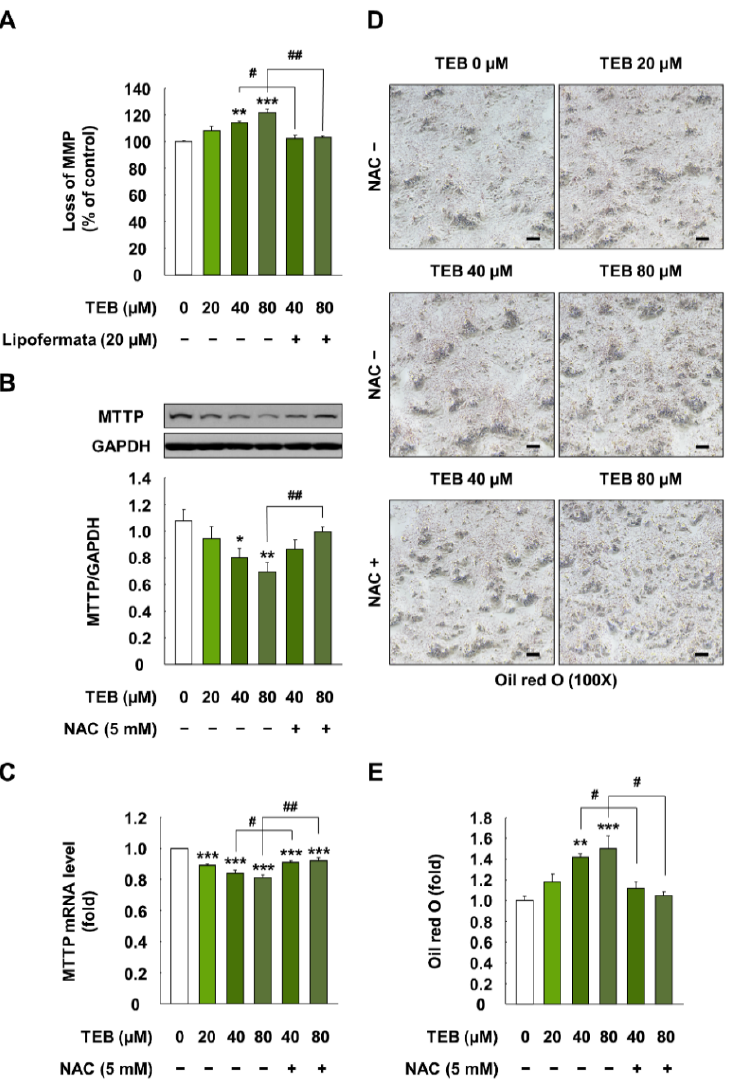
Figure 5. MMP and expression of lipid export-associated cellular indicators in HepG2 cells treated with TEB. ( A ) Loss of MMP in HepG2 cells; ( B ) protein and ( C ) gene expression levels of MTTP (1:3000 dilution) in HepG2 cells; ( D ) microscopy images (100×, black bar = 100 µm) and ( E ) quantification of areas stained with Oil Red O in cells. The cells were exposed to 20, 40, and 80 µM TEB for 24 h with or without pretreatment with 20 µM Lipofermata or 5 mM NAC for 1 h ( n = 3 wells/group). GAPDH was used as a housekeeping control. The data are presented as mean ± SEM. * ( p < 0.05), ** ( p < 0.01), and *** ( p < 0.001) show a significant difference, compared to the control (DMSO). # ( p < 0.05) and ## ( p < 0.01) show a significant difference, compared to the TEB-treated cells.